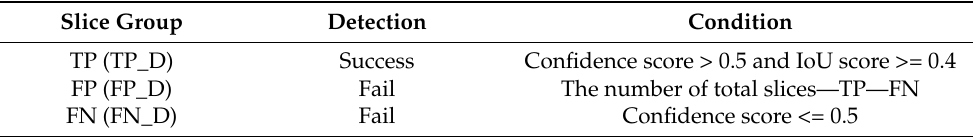
Table 4. The confusion matrix for the AH detector.